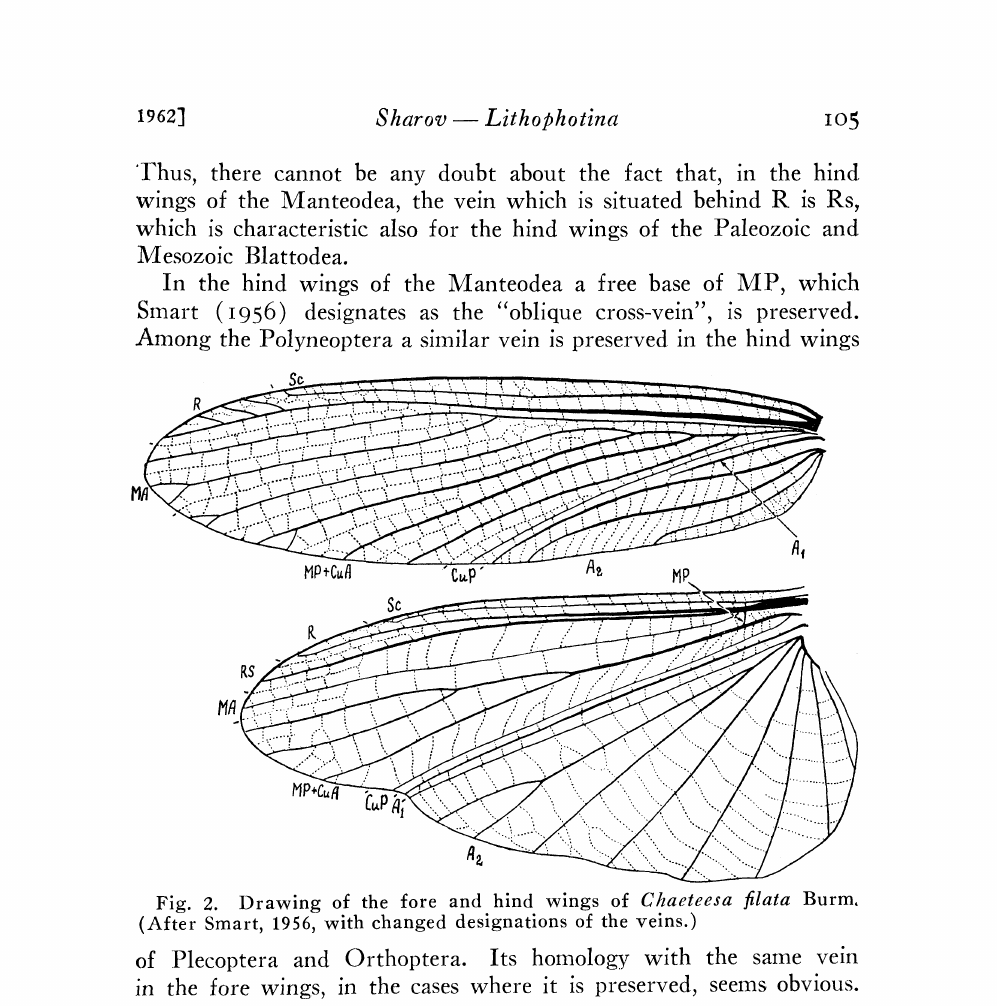
Fig. 2. Drawing of the fore and hind wings of Chaeteesa filata Burro, (After Smart, 1956, with changed designations of the veins.) of Plecoptera and Orthoptera. Its homology with the same vein in the tore wings, in the cases where it is preserved, seems